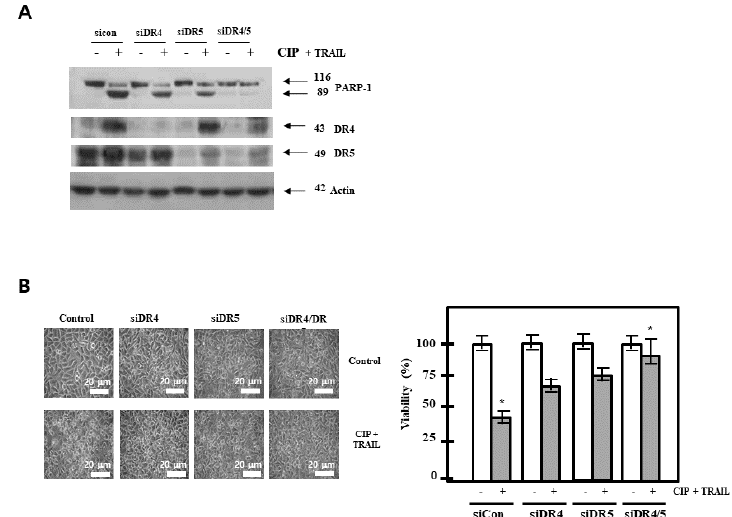
Figure 4. Effect of death receptors knockdown on CIP-induced sensitization to TRAIL. ( A ) A549 cells were transfected with DR5 siRNA, DR4 siRNA, and combined DR5 and DR4 siRNA. After 48 h, the cells were pretreated with CIP for 20 h and then treated with TRAIL for 4 h. Whole cell extracts were analyzed by western blotting using antibodies against PARP, DR4, and DR5. ( B ) Cell death was determined by Annexin V/PI staining. Scale bar = 20 µ m. The bar represents the mean ± SD. * p < 0.01 indicates a significant difference between the untreated control and CIP + TRAIL-treated samples.